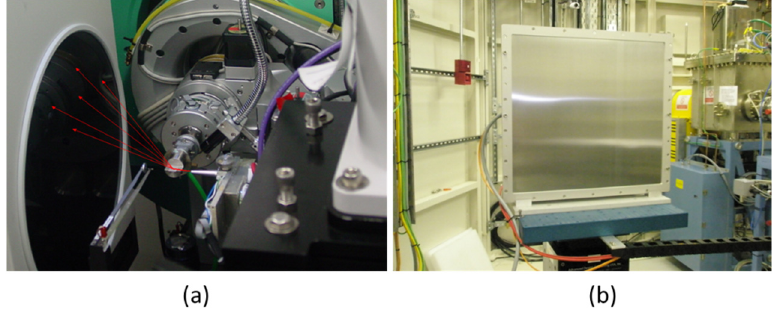
Figure 7. ( a ) MAR345 detector at SSRL beamline 11-3. X-ray trajectory is represented by red arrows; ( b ) Pixium RF4343 detector, covered with Al front plate, at Diamond Light Source beamline I12.